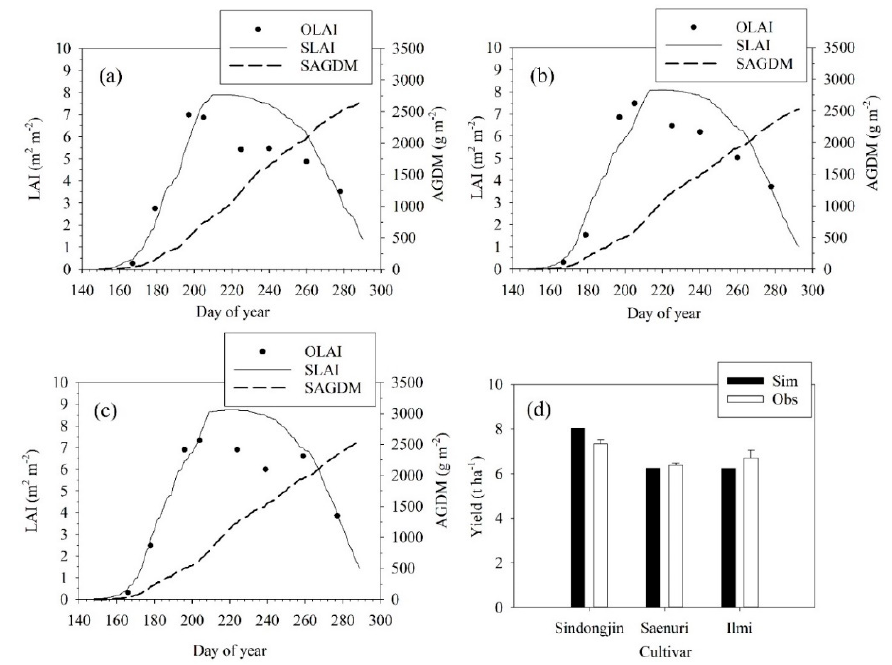
Figure 5. Simulated (S) and observed (O) leaf area index (LAI) and simulated above ground dry mass (SAGDM) of Sindongin ( a ), Saenuri ( b ), and Ilmi ( c ), and comparison between simulated (Sim) and observed (Obs) yields ( d ) at Buan and Gimje, Chonbuk, S. Korea in 2014 for model validation.